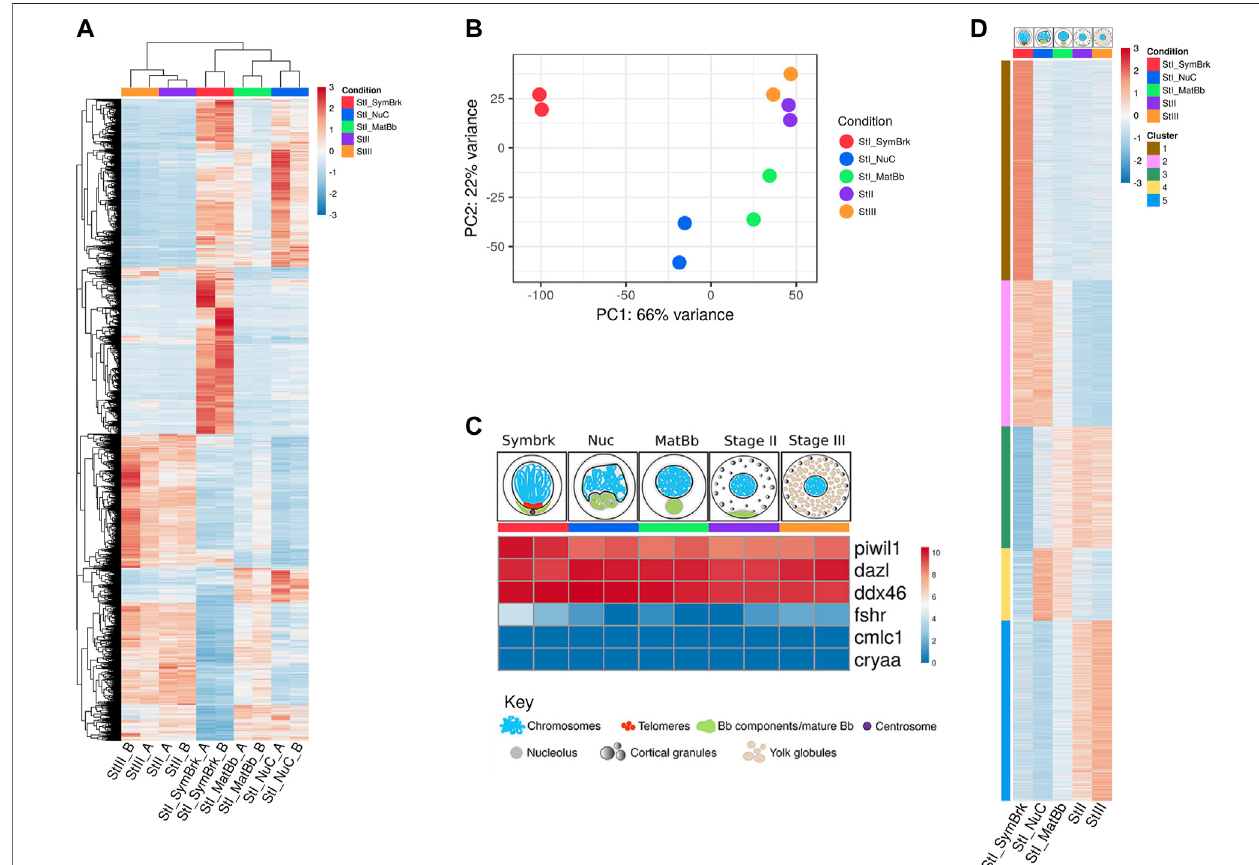
FIGURE1| Ahighthroughputanalysisof5stages ofoocyte development. (A) Unsupervisedhierarchicalclustering ofall genesthatwere changed betweenany of thestages.Samplesareorderedaccordingtoclustering. (B) PCAoftheduplicatesofthedifferentstages. (C) Controlgeneexpressioncon fi rmstheaccuracyofourdata. Germ cellspeci fi cgenesare expressed,but somatic markers show backgroundexpression comparable with expression ofnon-ovarian genesimages ofoocyte stages groups were modi fi ed from Elkouby and Mullins (Elkouby and Mullins 2017a). (D) Heat map of k-means clustering of genes that were differentially expressed as determined by a likelihood ratio test. Five clusters were determined to allow visualization of the expression trends. Each stage is represented by a color throughout the fi gures: red for Symbrk, blue for Nuc, green for MatBb, purple for Stage II, and orange for Stage III. Red denotes higher expressed genes and blue denotes lower expressed genes. The numbers are normalized relative expression. Each column is the average of the duplicates.